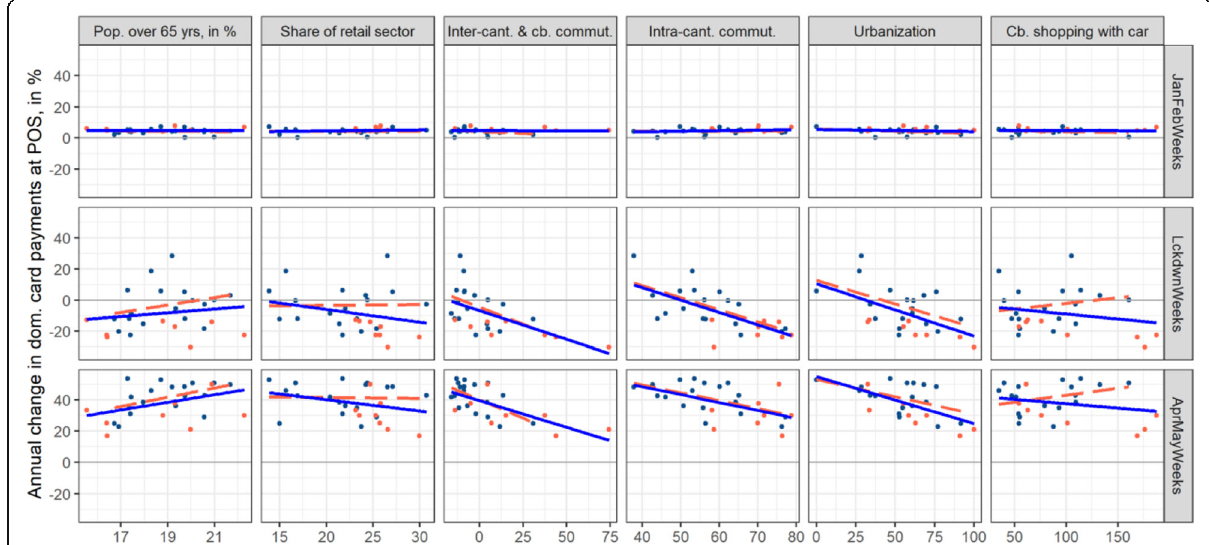
Fig. 10 Excess domestic card-present retail payments versus further sources of shifts per canton. Source: Own calculations, Worldline/SPS, SFSO